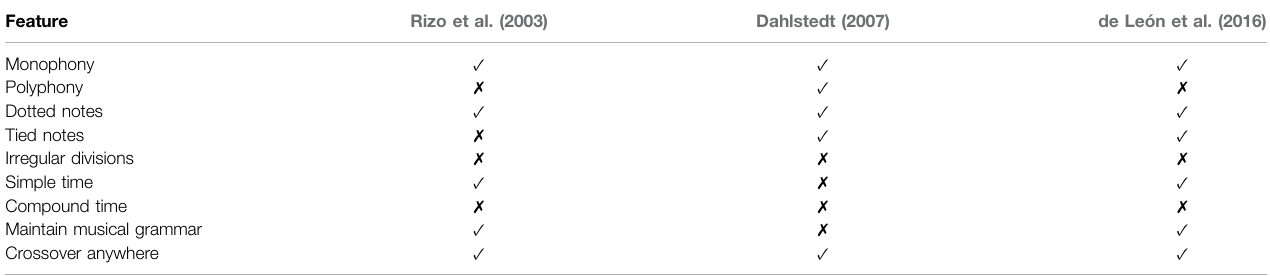
TABLE 2 | A comparison of the features of the melody trees proposed in the